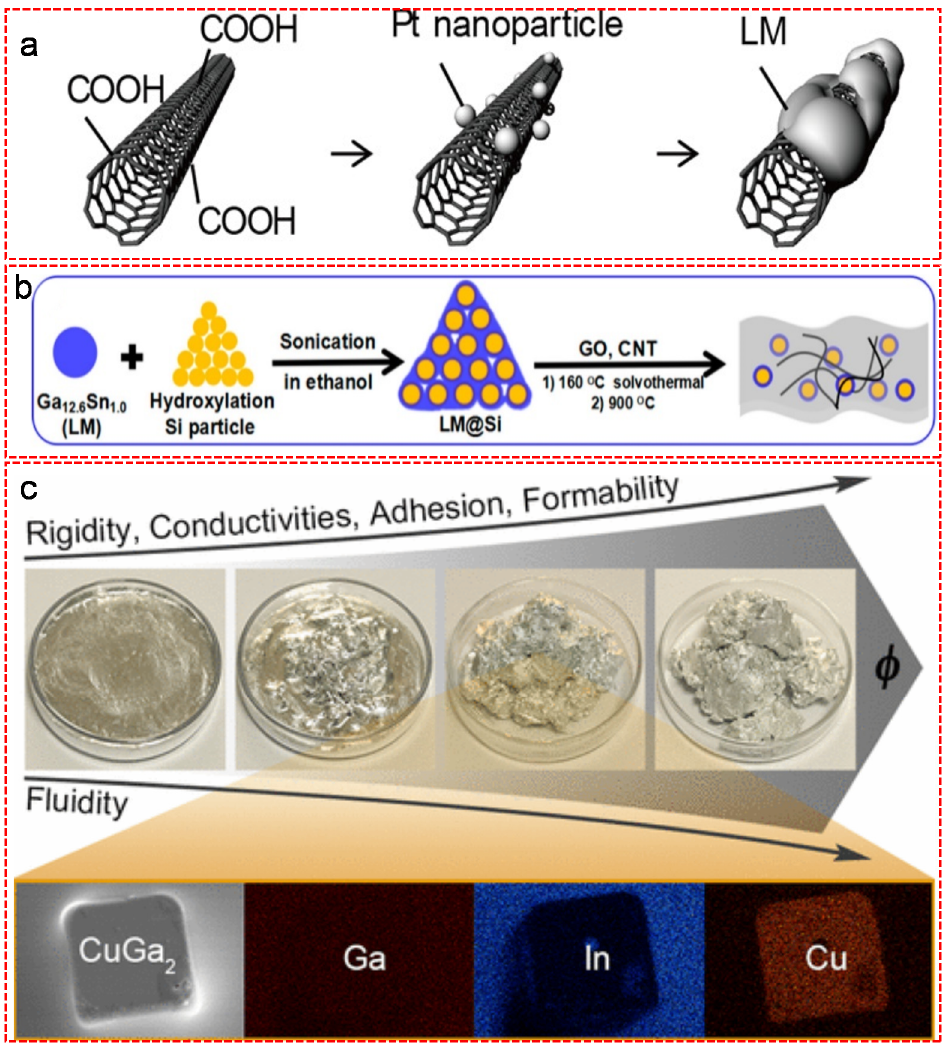
Figure 5. Synthesis of LM-inorganic nanoparticle composites. ( a ) Schematic illustration of the syn- thesis of CNT/LM composite by homogeneously dispersing CNTs modified with Pt nanoparticles in a liquid metal matrix. Reproduced with permission. [39] Copyright 2019, American Chemical Society. ( b ) Schematic illustration of the synthesis of Si/LM composite using CNTs and GO as the conductive network and skeleton. Reproduced with permission. [40] Copyright 2018, American Chemical Society. ( c ) The impact of Cu ratio on the physical properties of LM-Cu composite. Reproduced with permission. [41] Copyright 2017, American Chemical Society.